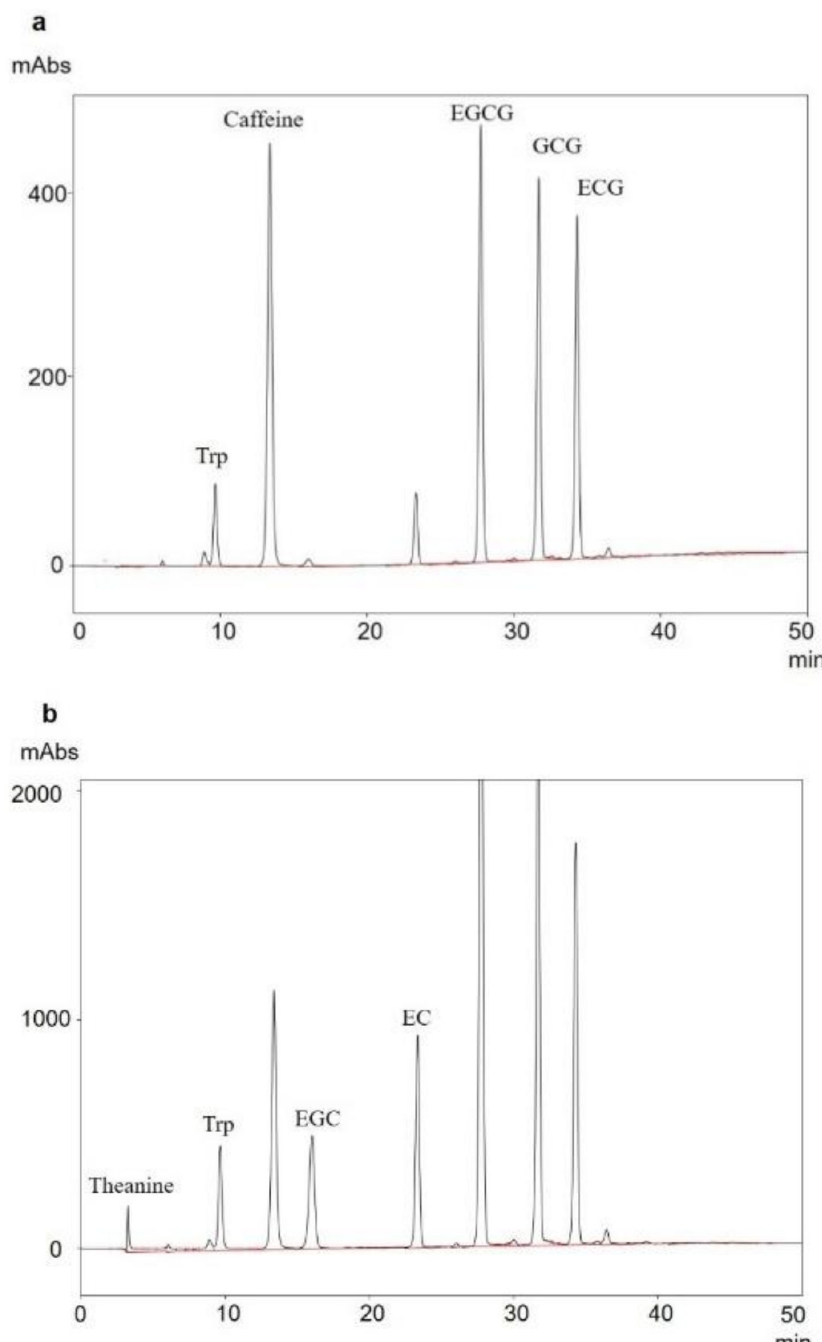
Figure 1. HPLC chromatogram of a standards solution comprising of internal standard (0.002% L-tryptophan (Trp)) and the target constituents (L-theanine 1 mM, caffeine 1 mM, EGC 0.25 mM, EC 0.25 mM, EGCG 1 mM, GCG 1 mM and ECG 0.25 mM) detected at UV ( a ) 280 nm and ( b ) 210